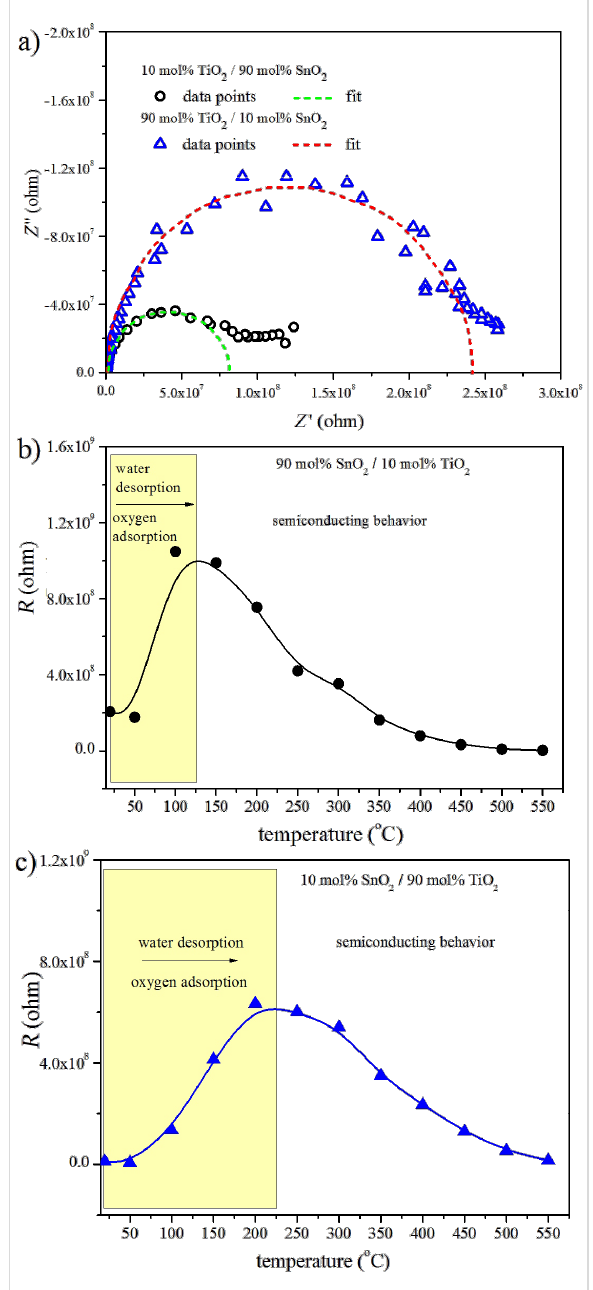
Figure 8: a) Impedance spectra of 90 mol % SnO 2 /10 mol % TiO 2 and 90 mol % TiO 2 /10 mol % SnO 2 at 400 °C along with the electrical resistance as a function of the temperature (b, c) obtained on the basis of impedance